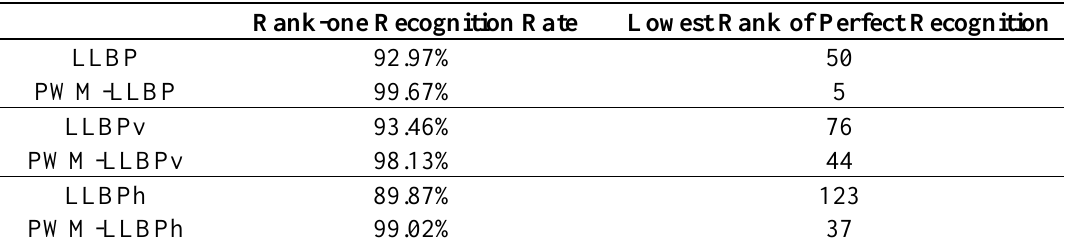
Table 7. Identification performance by different methods.